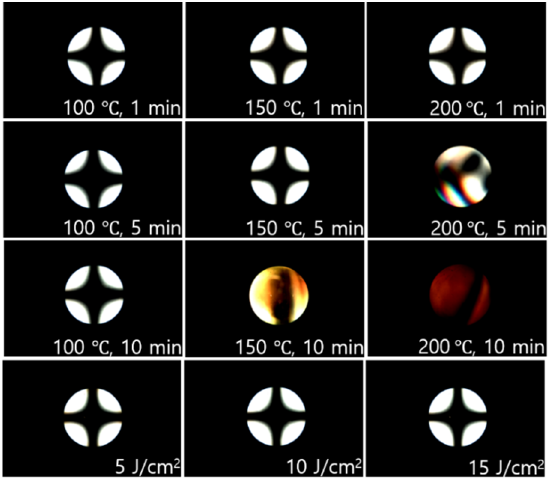
Figure 8. Concoscopic polarized optical microscopy images of the LC cells made using PIEU100 films, after thermal treatment at 100, 150, and 200 °C for 1, 5, and 10 min, and UV treatment at 5, 10, and 15 J/cm 2 , respectively.